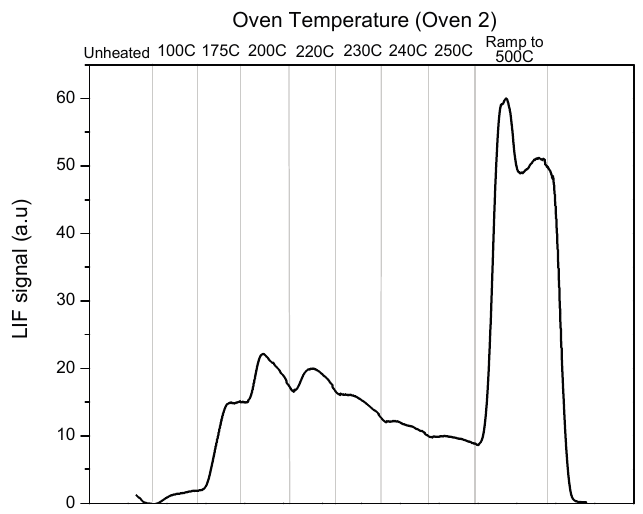
Figure 2. PTD profile using Oven 2 program for an uncoated tubular denuder loaded with pure HgCl 2